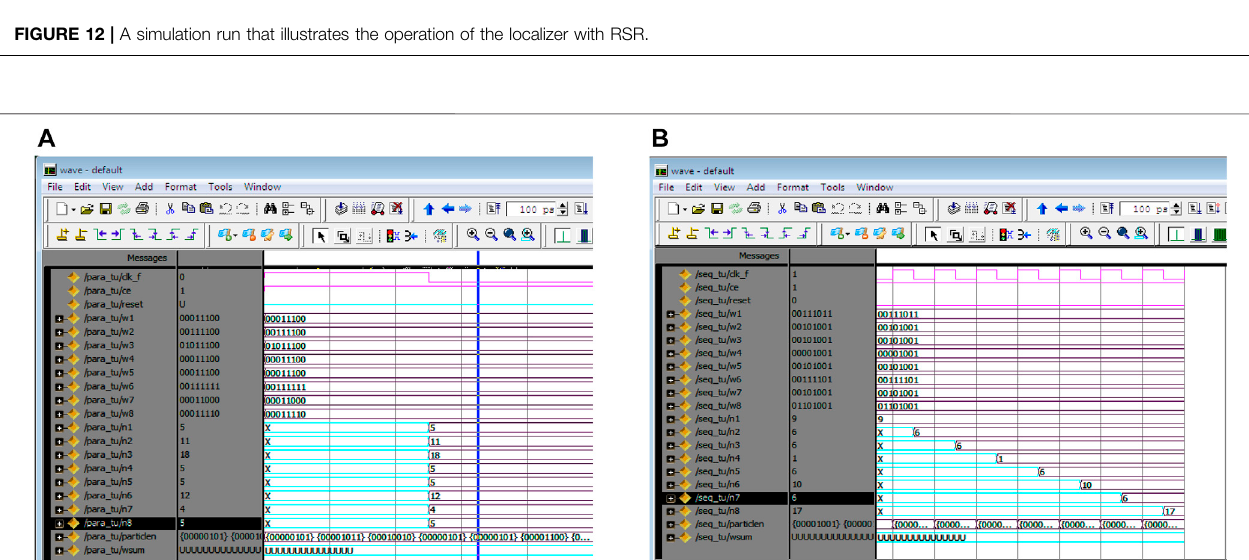
FIGURE 13 | The execution time comparison (A) The eight parallel resampling loops give the replication factors at one clock cycle. (B) One loop (sequential) RSR replicates factors after M clock cycles for M (cid:1) 8 .